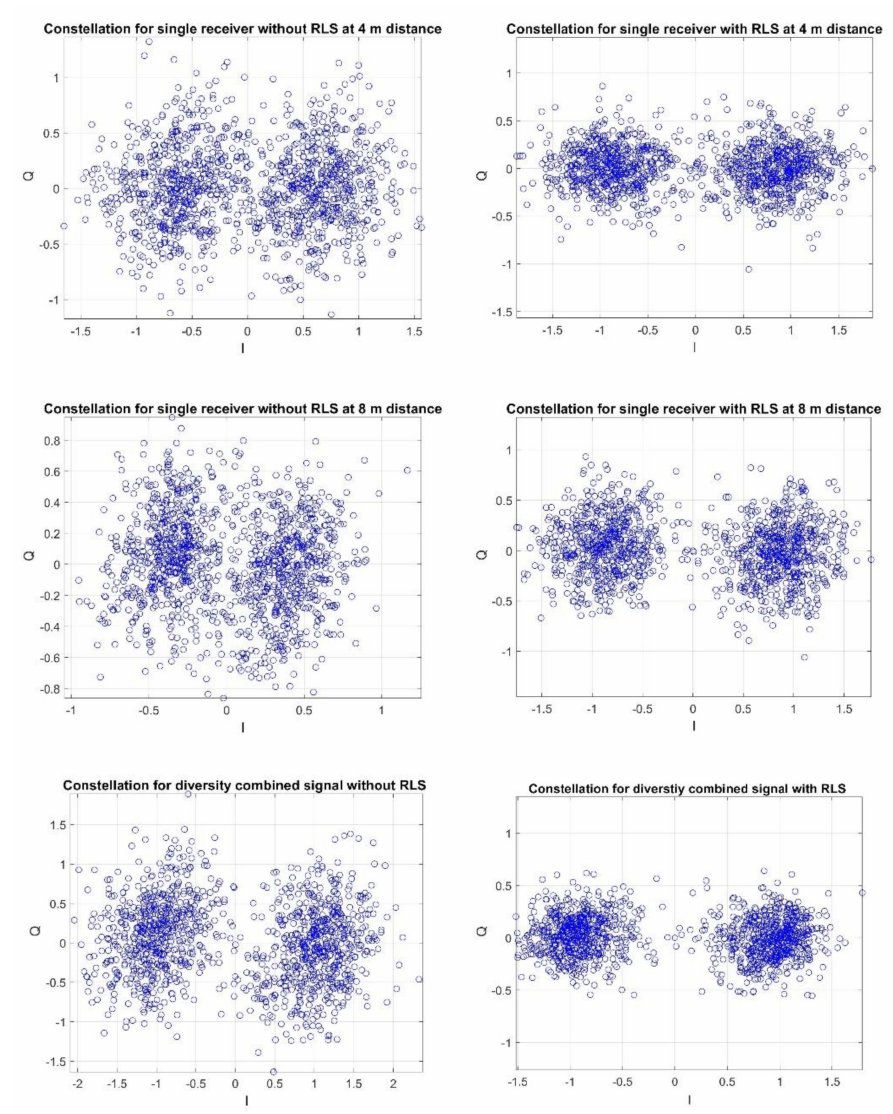
Figure 12. Example of a constellation for reception with hydrophones at the distance of 4 m and 8 m from the